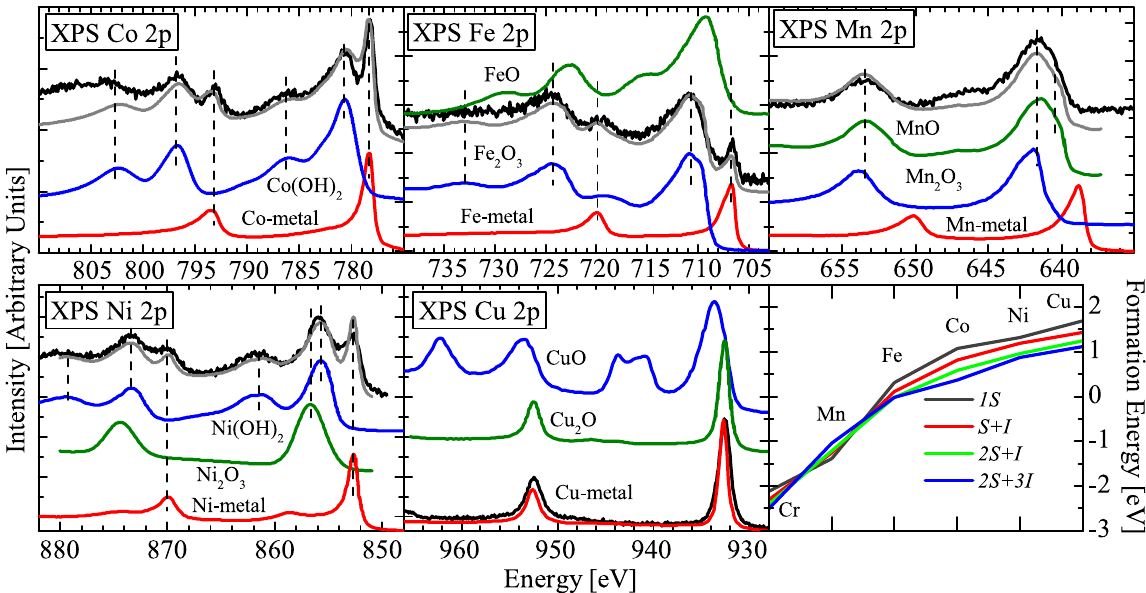
Figure 3. XPS spectra for doped samples. Black curves are 2 p excitations of the TM dopant atoms in Bi 2 Te 3 . Grey curves are a linear combination of standard references. Table 1 indicates the approximate proportion of each oxidation state the dopants are in. The lower right panel are DFT calculated formation energies for each dopant for four types of defects.